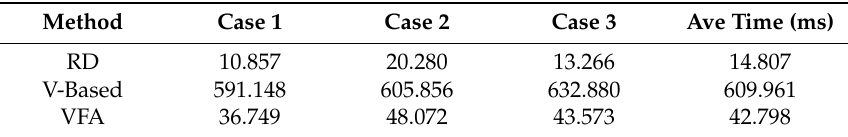
with static obstacles as shown in Figure 21. The